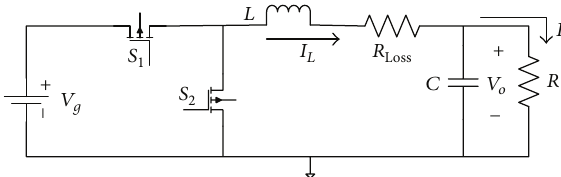
Figure 1: Typical structure of a Buck converter